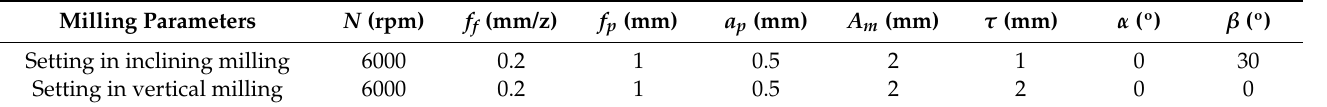
Table 2. Milling parameters for